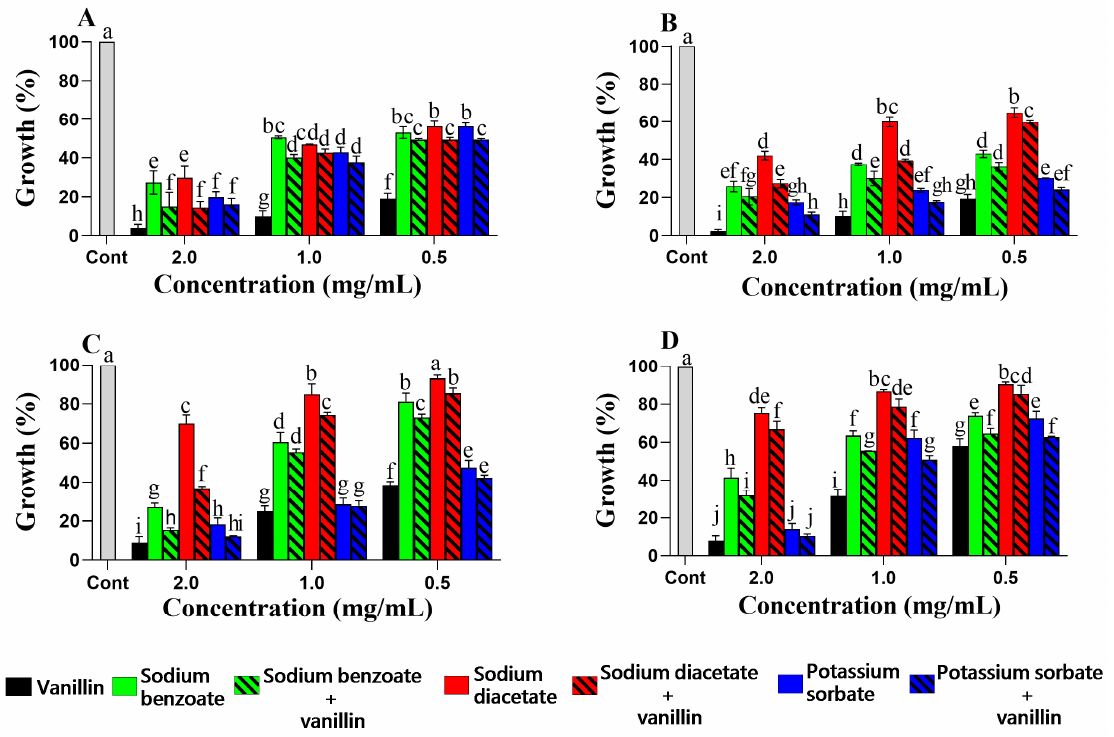
Figure 1. Effect of the antimicrobial agents on planktonic growth of D. hansenii SZMC 8045Mo ( A ), W. anomalus SZMC 8061Mo ( B ), S. pombe SZMC 1280 ( C ), and S. cerevisiae SZMC 1279 ( D ) when the (Cont.) represents growth in the absence of the compounds. The results are the mean percent growth indicate statistically significant differences ( p <